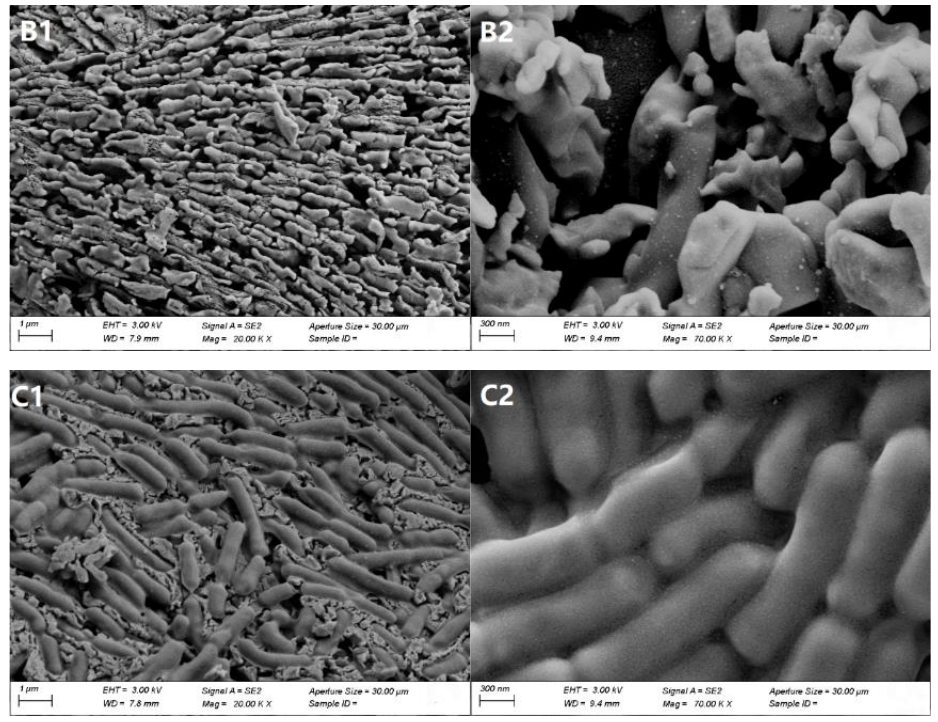
Figure 6. Representative scanning electron micrographs of ( A ) unrefrigerated L. rhamnosus , ( B ) saline-treated L. rhamnosus after freezing, and ( C ) L. rhamnosus treated with 1 mg/mL antifreeze peptides from defatted Antarctic krill (AKAPs) (H-AKAP) after freezing. ( 1 ) represents 20,000-fold magnifications and ( 2 ) represents 70,000-fold magnifications.